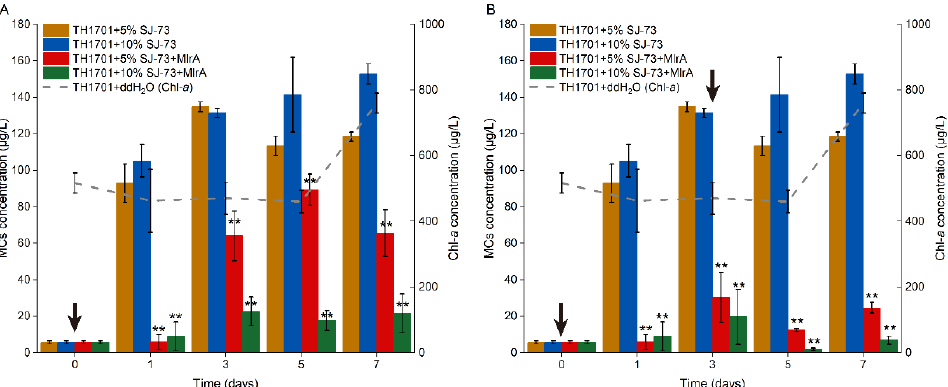
Figure 7. Changes on extracellular MCs concentration in colonial M. aeruginosa TH1701 culture treated with bacteria SJ-73. Black arrows represent the the day for adding MlrA in algal culture. The ( A ) MlrA was added into algal culture at the beginning of the experiment, and ( B ) the MlrA was added into algal culture at the beginning of the experiment and on the third day. Bars represent the standard errors of the means for triplicate. Significant differences are shown by asterisks: **, p < 0.01.